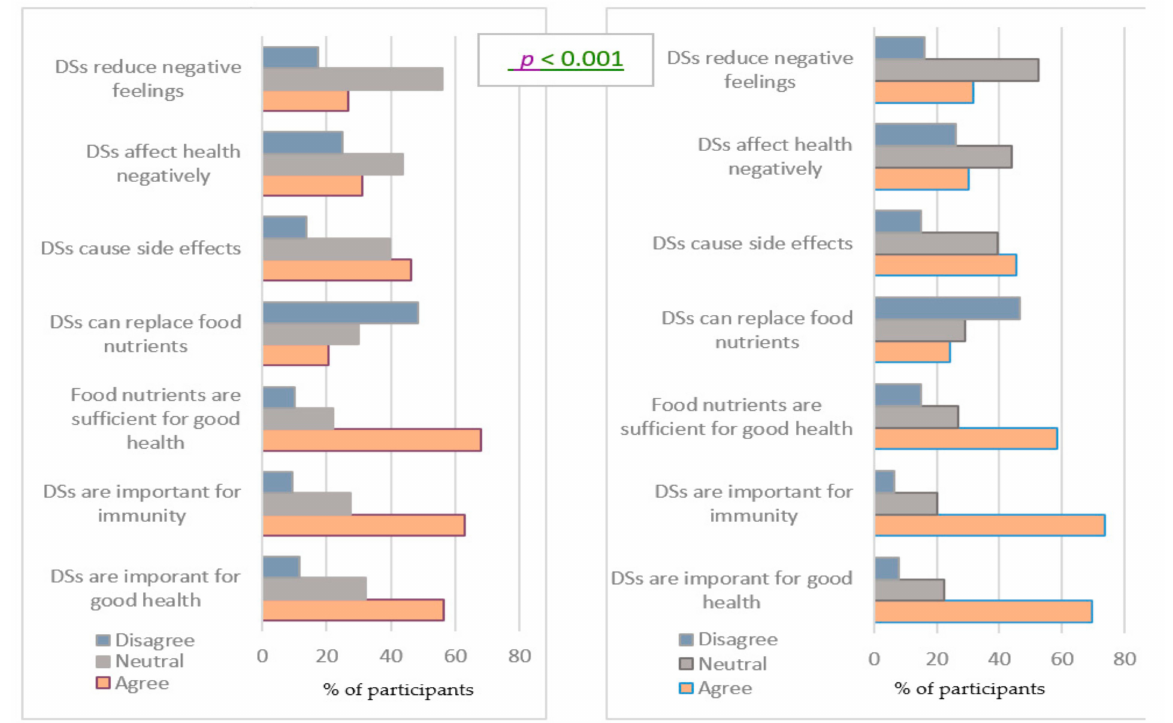
Figure 2. Attitudes towards DSs beneficial use, before and during COVID-19 pandemic.